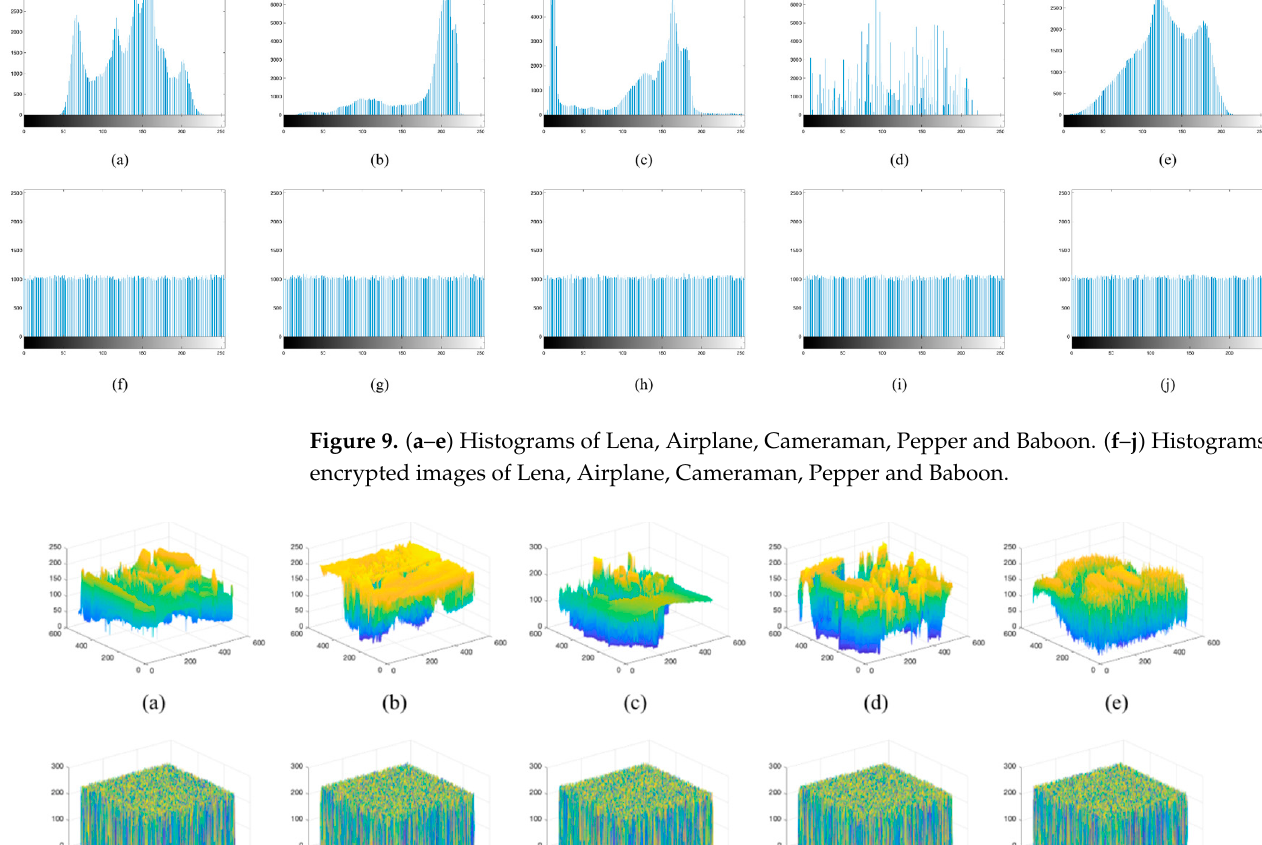
Figure 8. ( a ) Goldhill (256 × 256). ( b ) Cipher using original key. ( c ) Cipher using changed key. ( d )